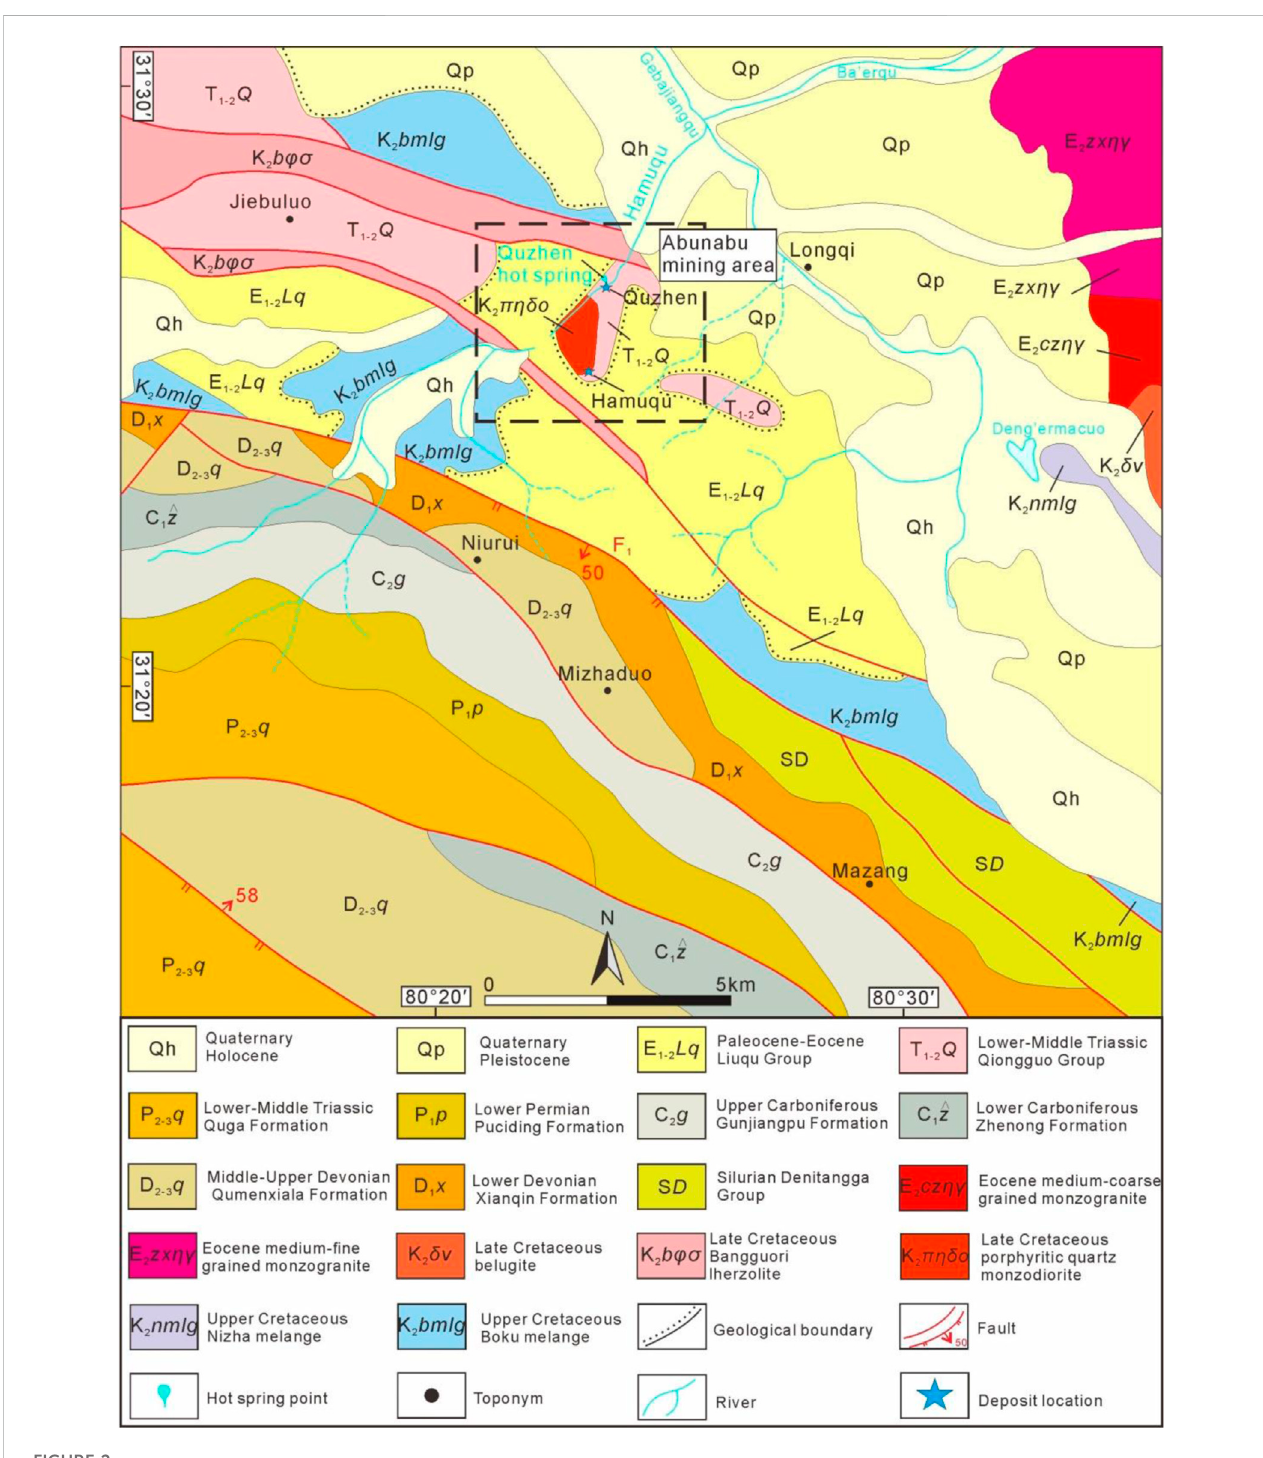
FIGURE 2 Regional geological map of Abunabu antimony ore concentration area (Zhang et al.,